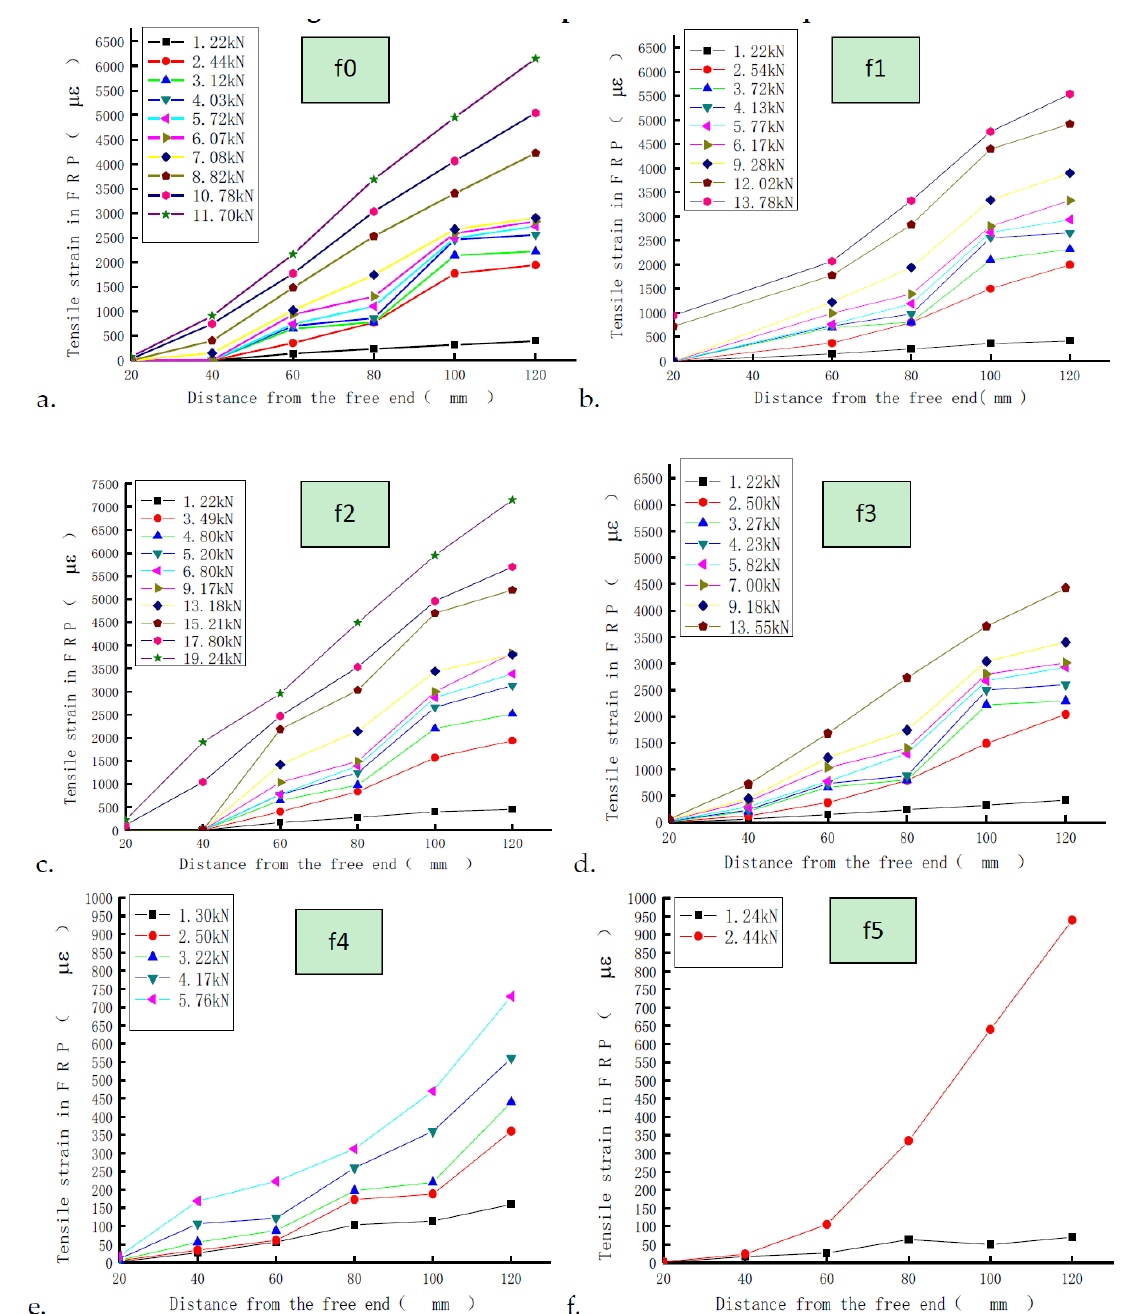
Figure 10. Strain – position relationship of the six types of interface specimens (C40 specimen). (a: f0; b; f1; c: f2; d: f3; e: f4; f: f5).